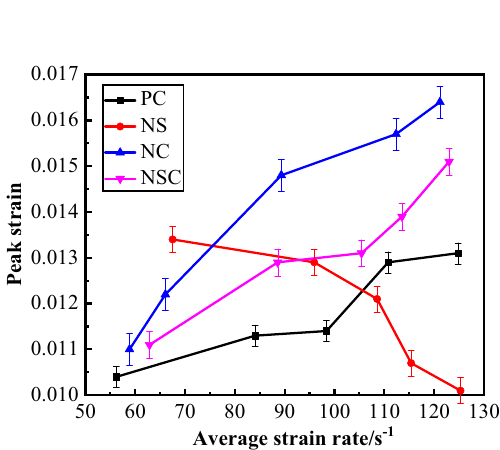
Figure 14. Relationship between peak strain and average strain rate of